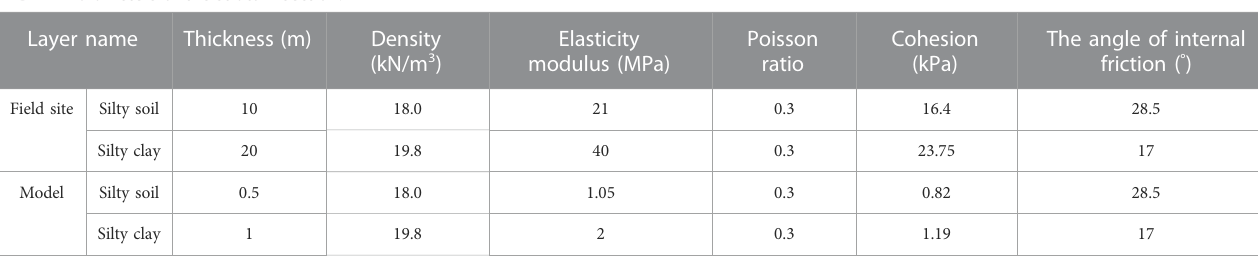
TABLE 2 Parameters of the stratum